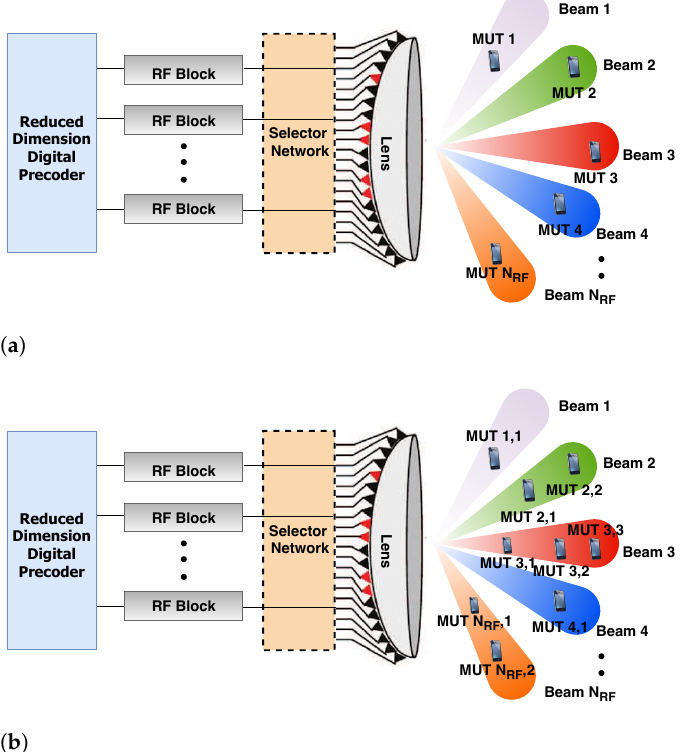
Figure 1. Network architectures: ( a ) Beamspace MIMO. ( b ) Beamspace mMIMO